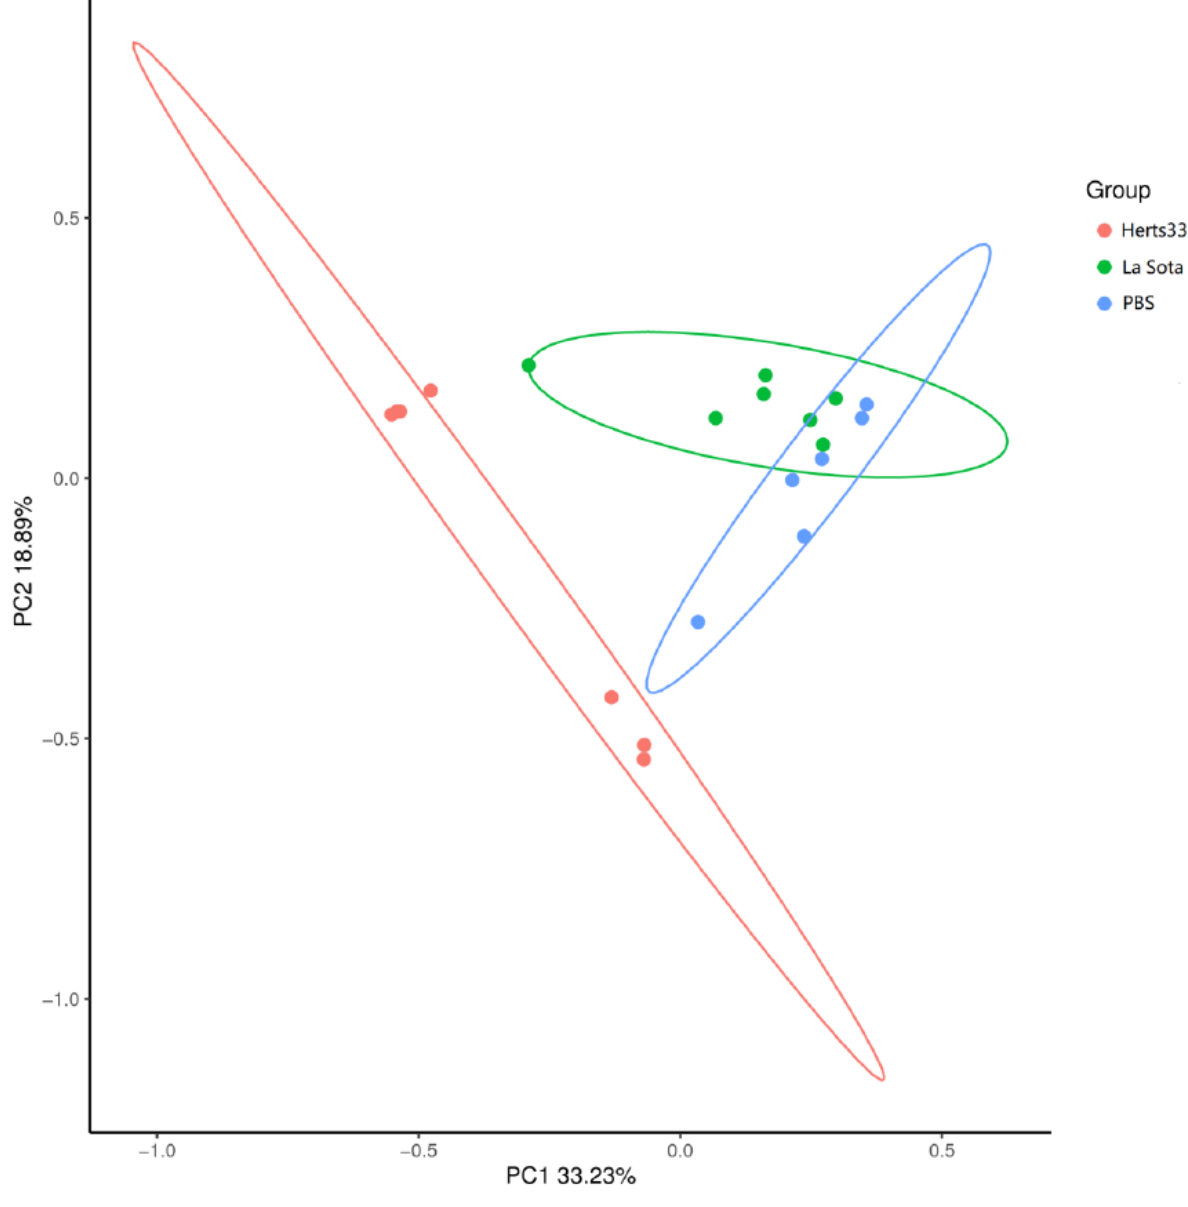
Figure 3. PCoA analysis of similarities between different groups. Principal component (PC) 1 and 2 accounted for 33.23% and 18.89% of the variance, respectively.